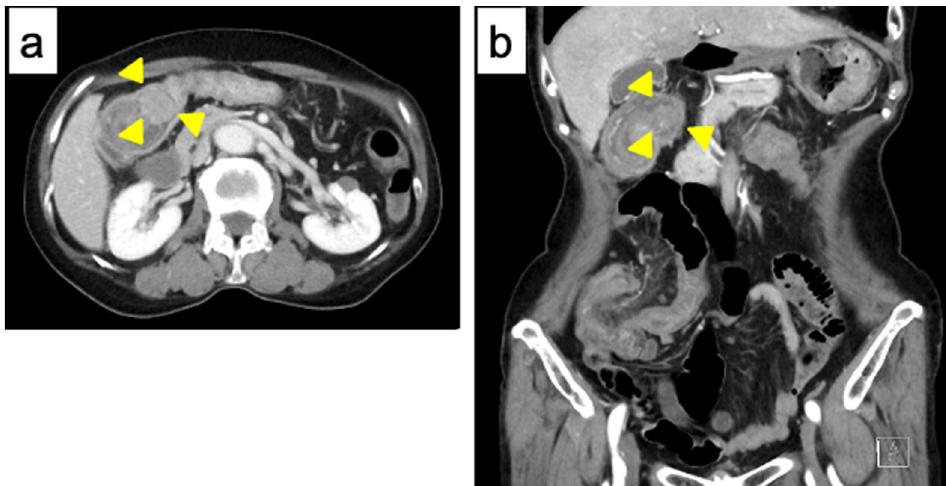
Fig. 1 An abdominal contrast CT scan. Target sign is detected in the ascending colon in right upper abdomen, which indicates intussusception. a Axial views. b coronal views. Arrowhead: a lead point